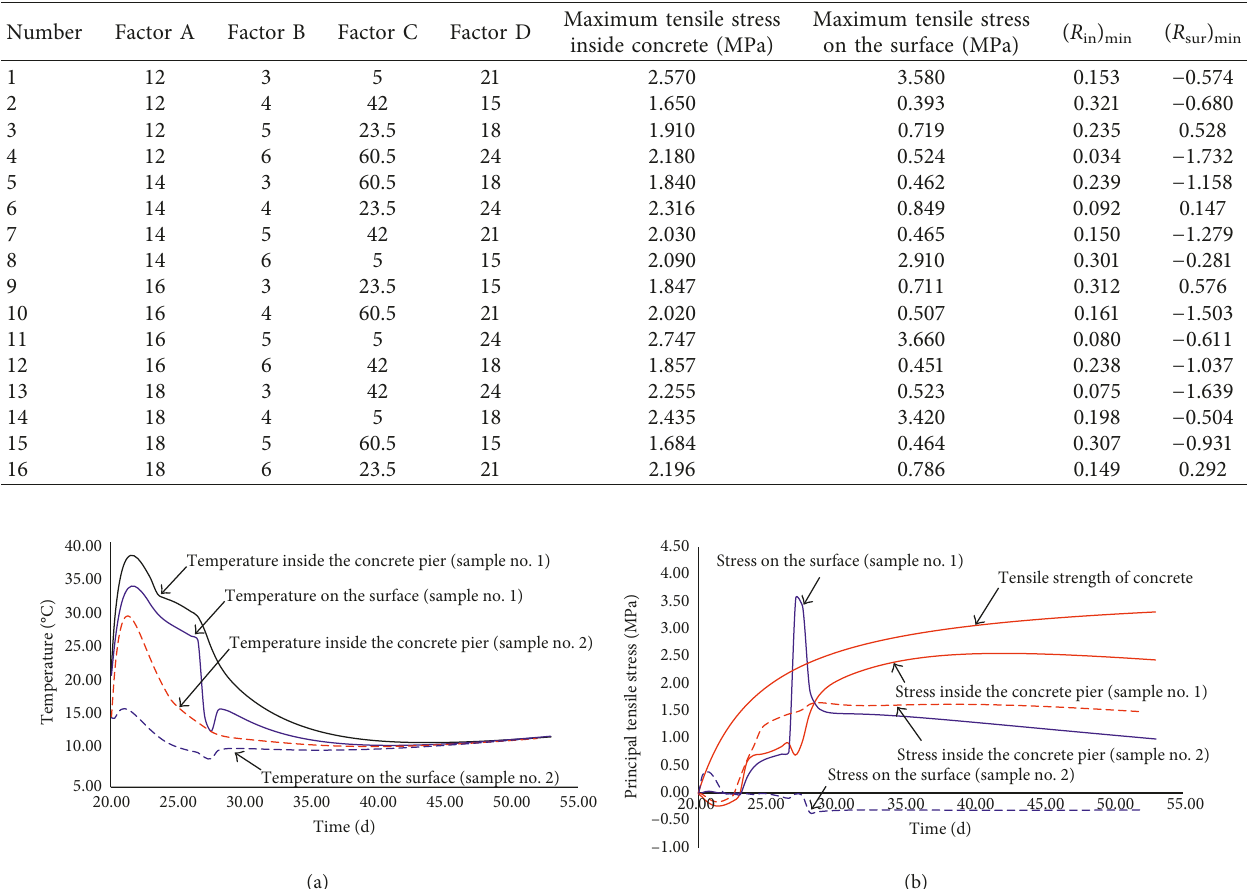
Table 3: The learning samples for the neural network model based on the uniform design method.